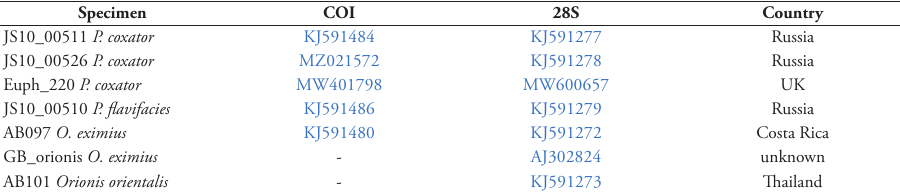
Table 1. GenBank accession numbers for Orionis sequences.